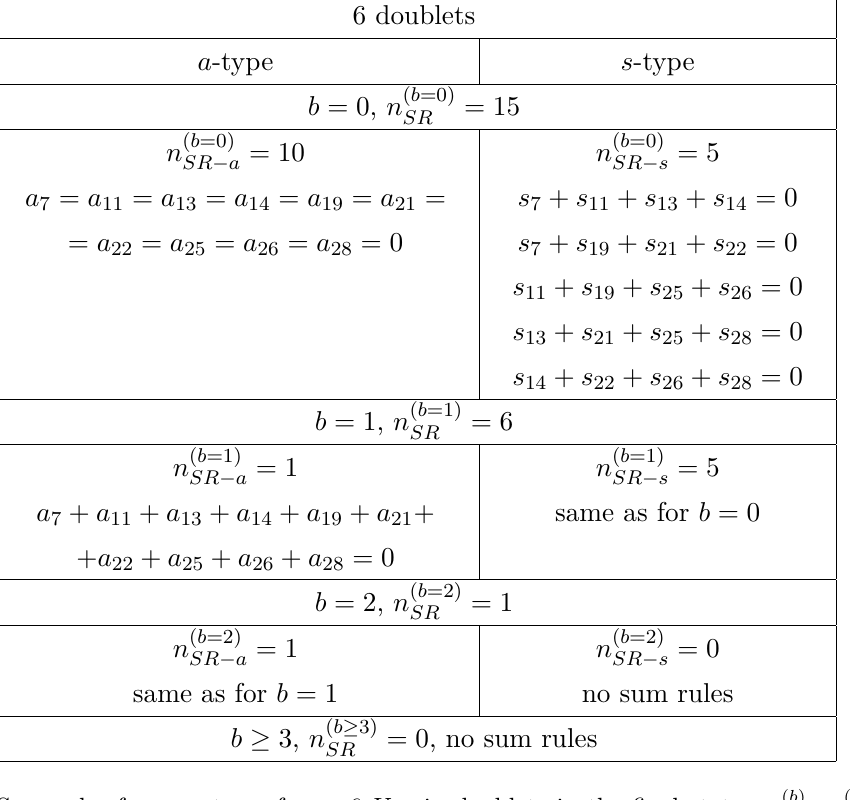
Table 2 . Sum rules for a system of n = 6 U -spin doublets in the final state. n ( b ) denote the total number of sum rules, the number of a -type sum rules and the number of n ( b ) SR − s s -type sum rules that are valid at the order of breaking b